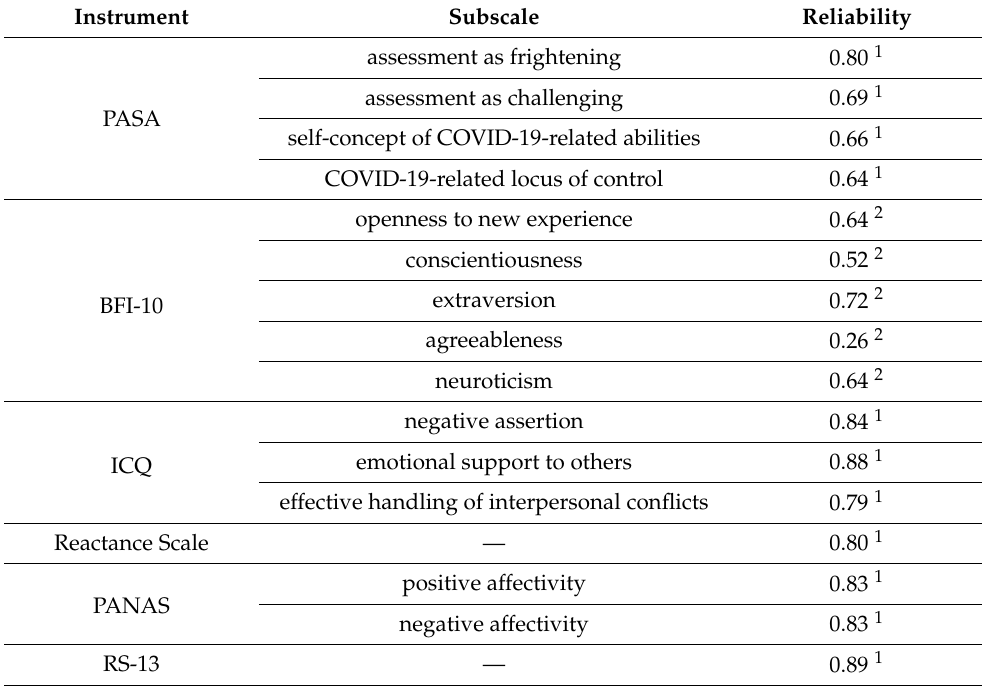
Table 1. Detailed internal consistencies of the used standardized instruments for the present sample. Instrument